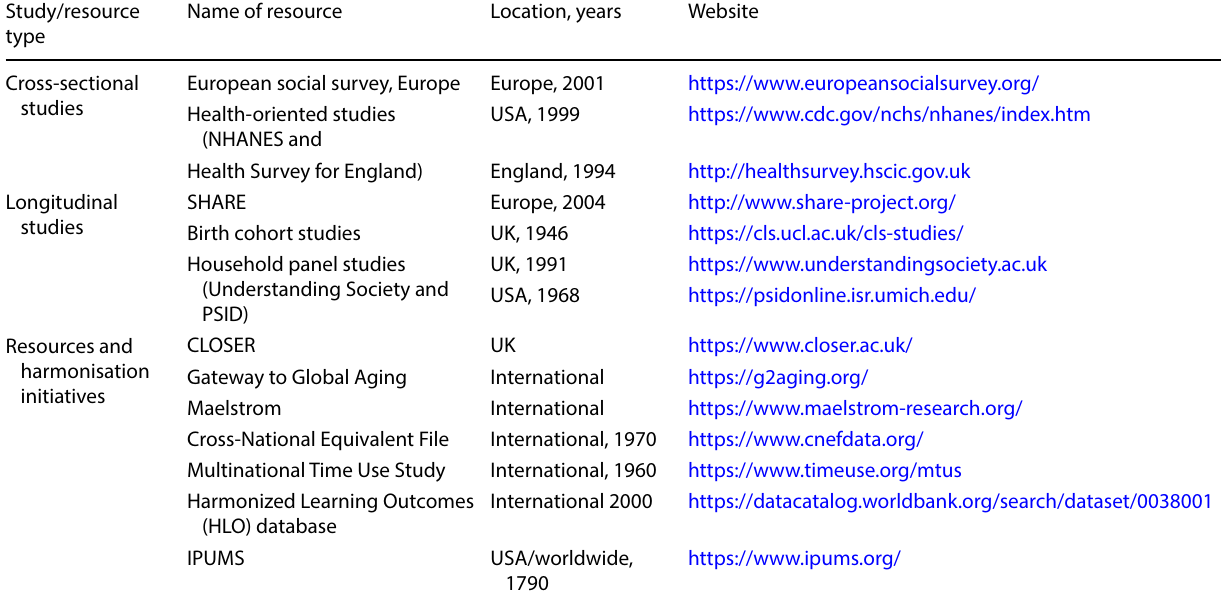
Table 2 Illustrative resources to aid investigation of change across time in prevalence or association